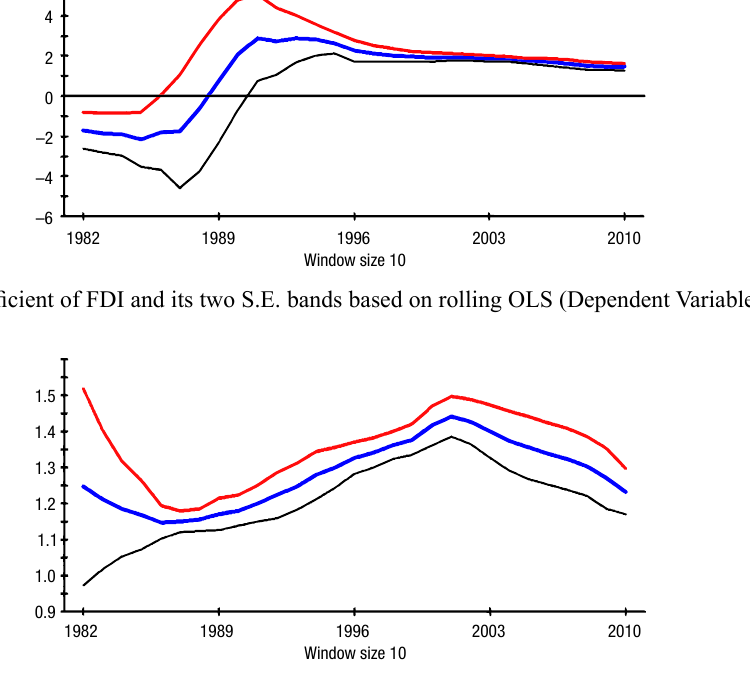
Fig. 4. Coefficient of REM and its two S.E. bands based on rolling OLS (Dependent Variable: